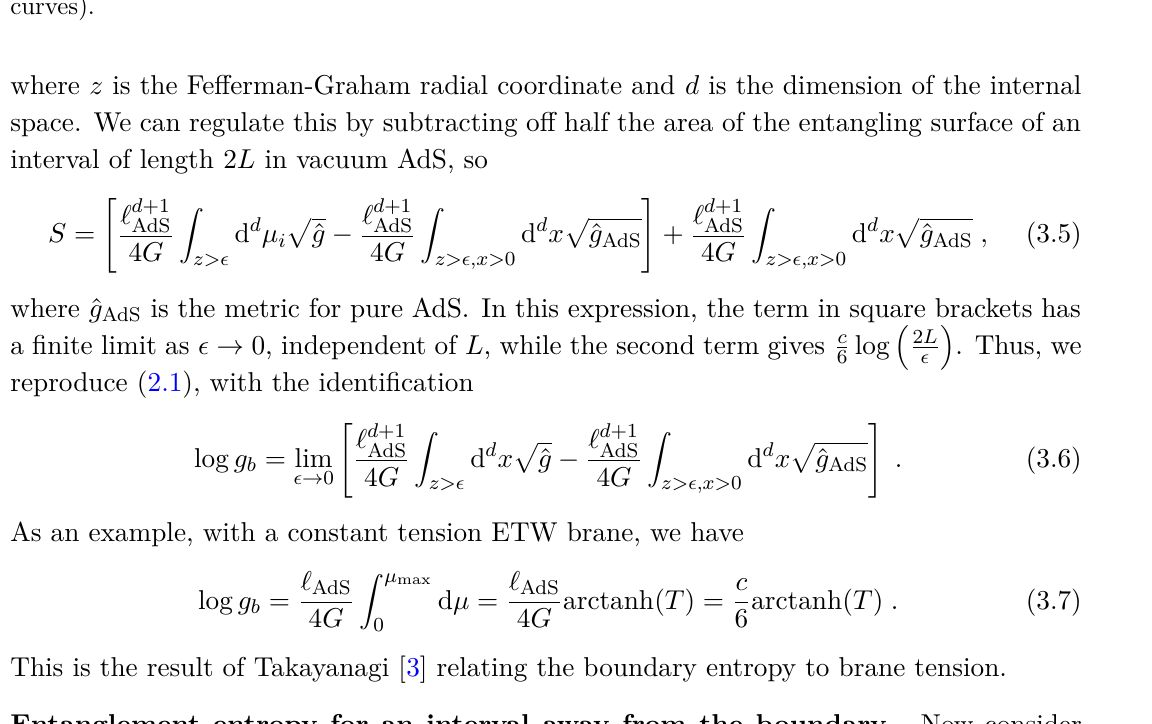
Figure 3 . Holographic calculation of entanglement entropy for an interval A away from the bound- ary. The RT surface has two possible topologies, a connected (solid curve) and disconnected (dashed